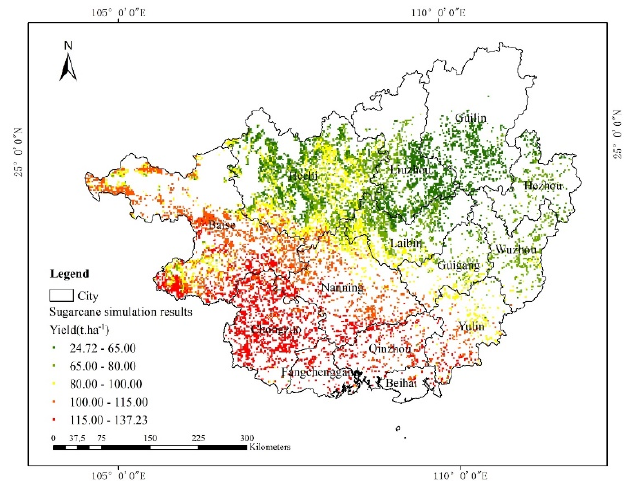
Figure 8. Spatial distribution of simulated sugarcane yield on the marginal lands in the Guangxi Zhuang Autonomous Region.